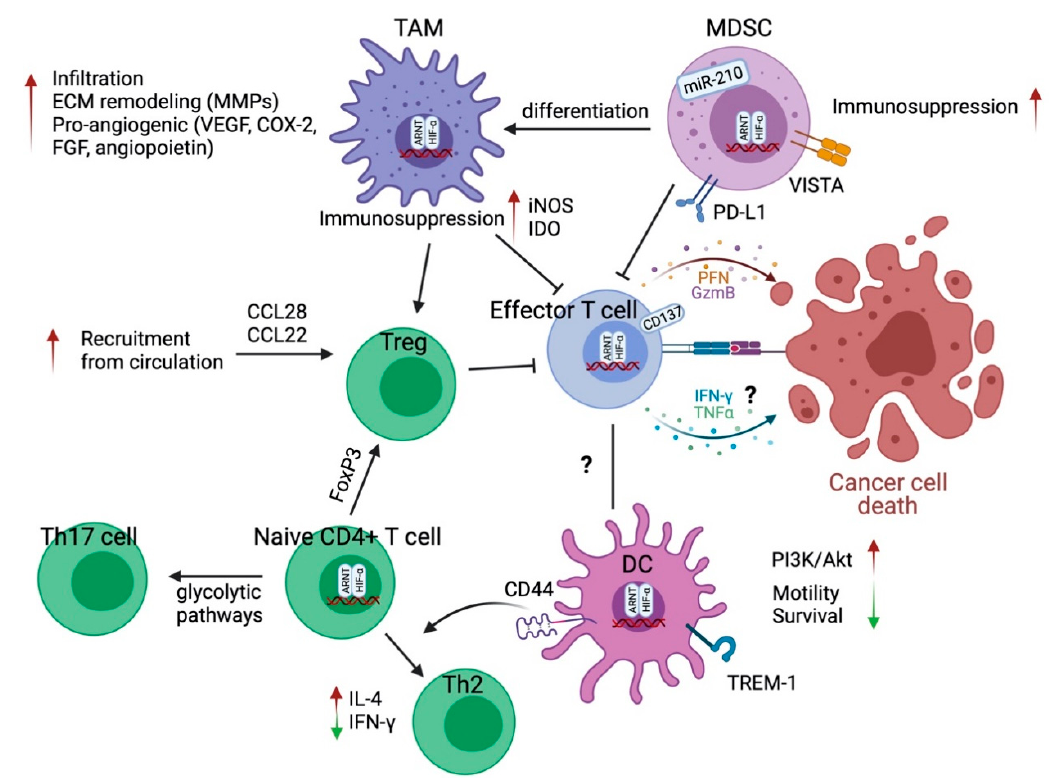
Figure 2. HIF signaling effects on immune cells in the tumor microenvironment. HIF signaling, mainly HIF-1 α generally promotes an immunosuppressive microenvironment. In TAMs and MDSCs, HIF-1 α contributes to their infiltration and enhanced suppressive capacity on effector T cells. HIF-1 α can also stimulate a proangiogenic phenotype of TAMs and TAM-mediated ECM remodeling. The hypoxic microenvironment stimulates the secretion of cytokines and chemokines from tumor cells or TAMs to recruit Tregs, further limiting effector T cell function. There is conflicting evidence of HIF signaling in determining T cell fate. HIF-1 α has been demonstrated to induce or inhibit differentiation of naïve CD4 + T cells into Th17 T cells or Tregs. HIF-1 α signaling also exhibits controversial effects on effector T cell function and the migration and maturation of DCs. The effect of hypoxia on DC and T cell interaction is an area ripe for further investigation. Green arrow pointing down, decreased; red arrow pointing up, increased.